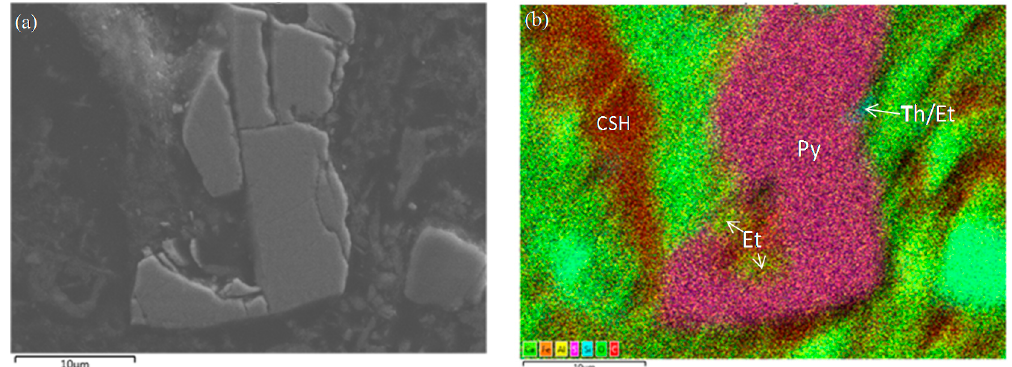
Figure 7. ( a ) BEI and ( b ) BEI colour model of ASS containing 4 wt % additional pyrite and treated with 15 wt % lime and 10 wt % slag at 365 days